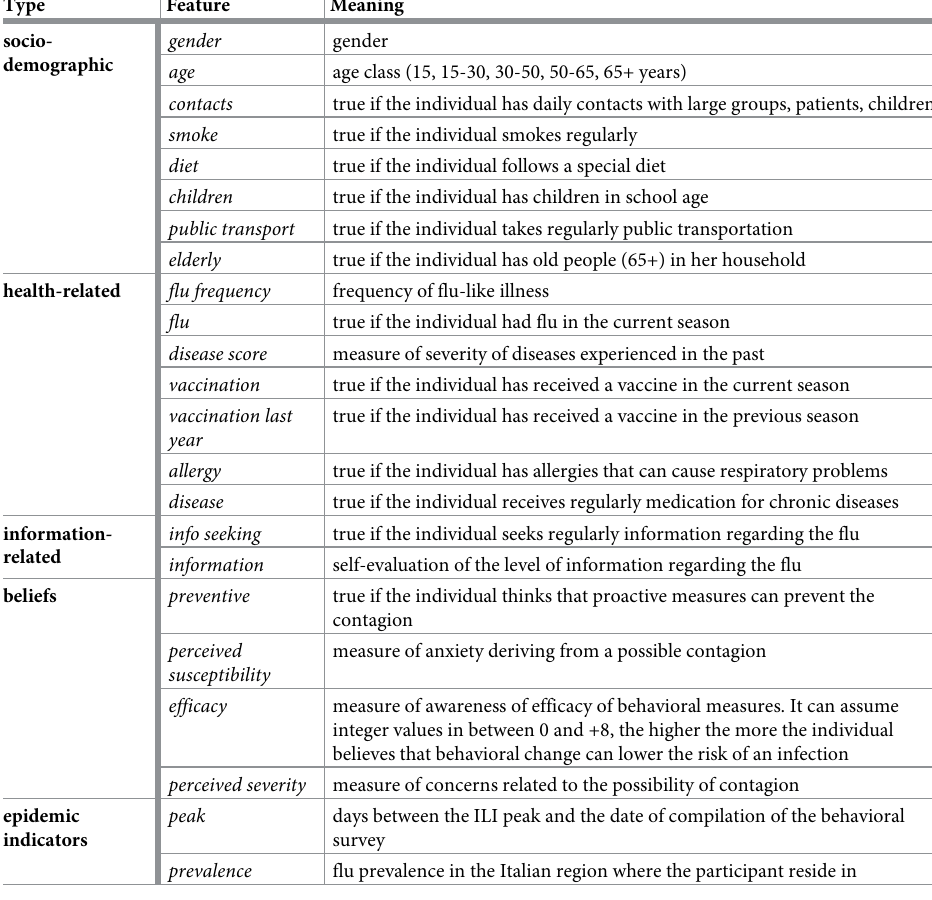
Table 1. List of